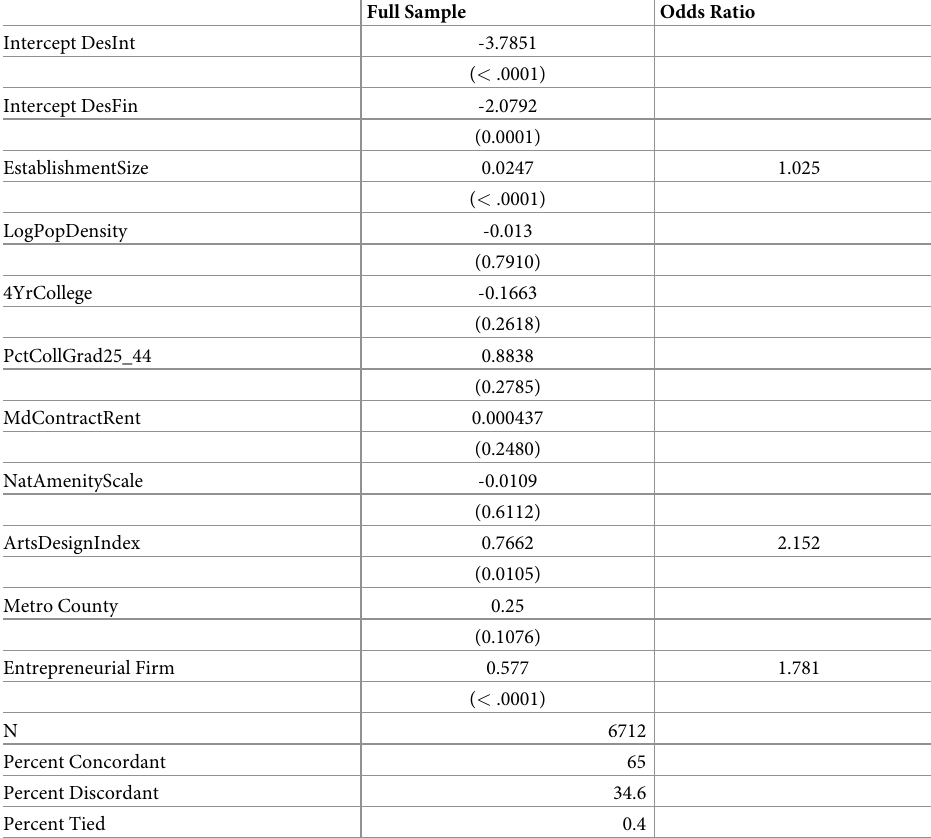
Table 4. Ordered logistic regression of innovation orientation for all establishments in